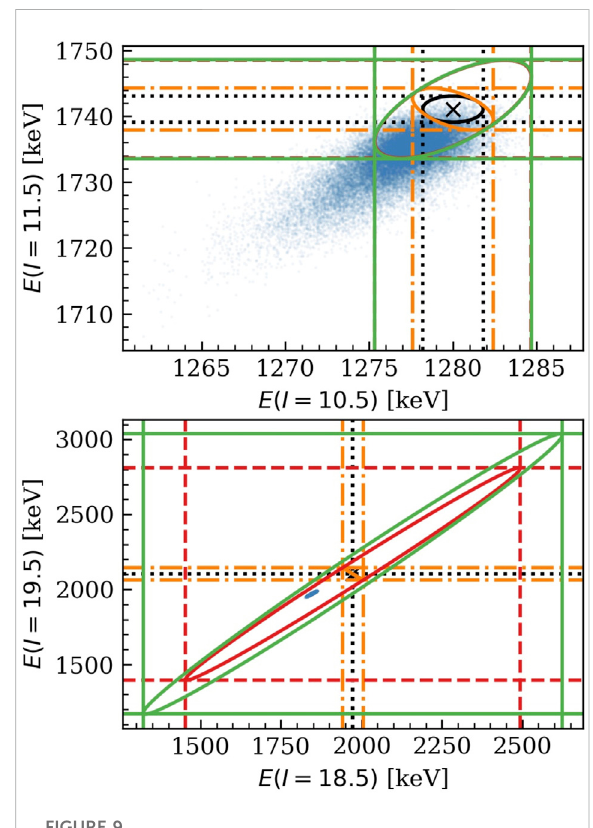
FIGURE 9 A 2D cut of the posterior predictive distribution at N 4 LO and k k 169 Erand I 235 U max =10for max =17.5(toppanel)andat max =18for and I max =23.5 (bottom panel). The blue dots show the energies calculated from the distribution of the LECs. The black cross shows the experimental value and the black lines and black ellipse shows the corresponding experimental uncertainty. The remaining ellipses and lines show the truncation error and the experimental error added in quadrature. (All the ellipses are centered at the experimental value.) The orange, red and green account for 1, two and six omitted terms in the theory error respectively (In the top panel the red ellipse is completely covered by the green